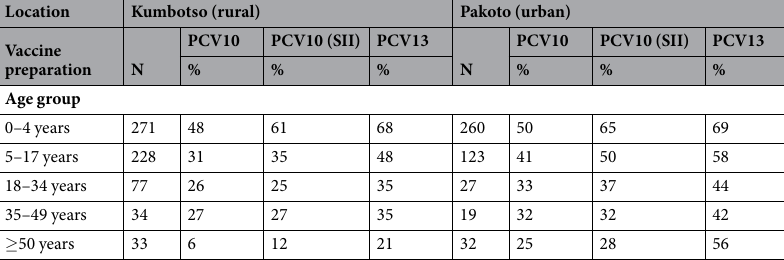
Table 3. Carriage Prevalence of Vaccine-Type Serotypes by location and by